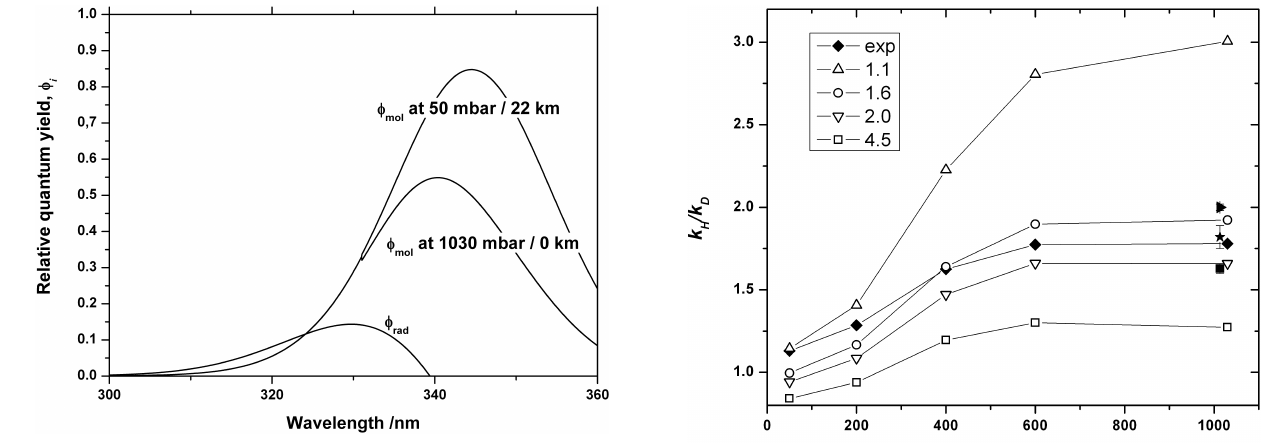
Fig. 5. The filled diamonds are averages of the experimental re- sults for k HCHO /k HCDO at different pressures presented in Table 2 and Fig. 3. Open symbols represent derived molecular channel isotope effects, k H / k D , when different radical channel corrections have been applied to the experimental data. Previous results for at- mospheric pressure measurements of the kinetic isotope effect in the molecular channel ( k H /k D ) are shown using a filled triangle (Rhee et al., 2008), a filled star (Feilberg et al., 2007) and a filled square (R¨ockmann et al.,